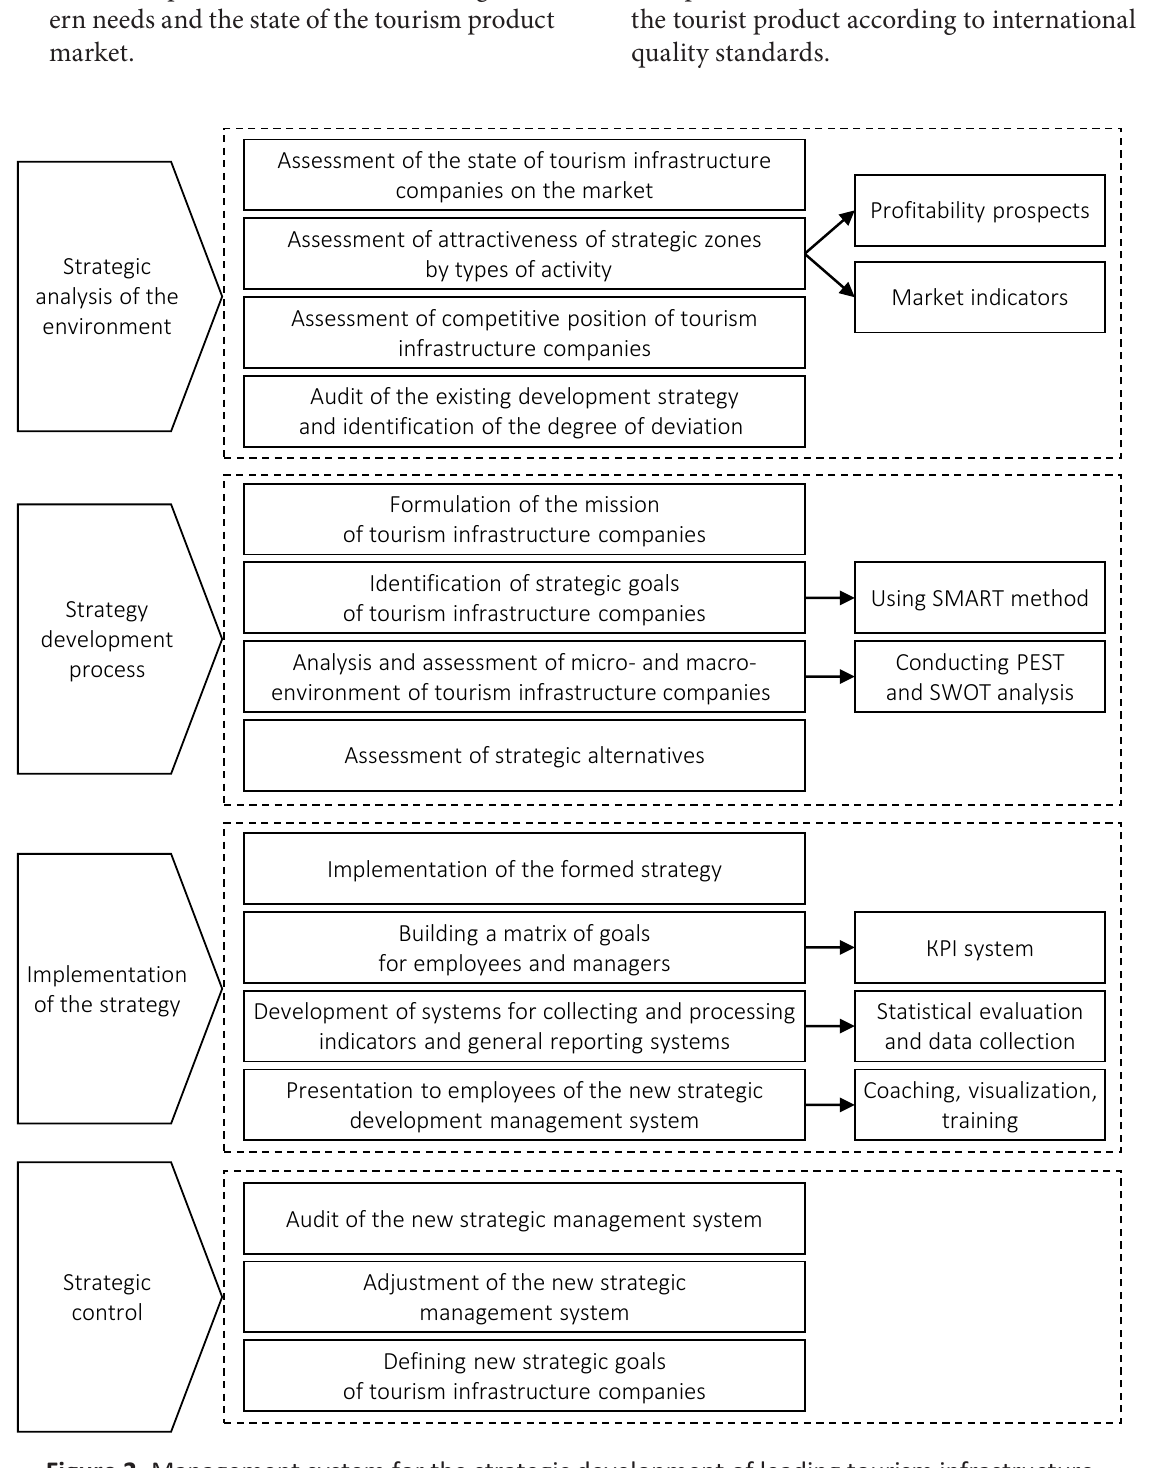
Figure 2. Management system for the strategic development of leading tourism